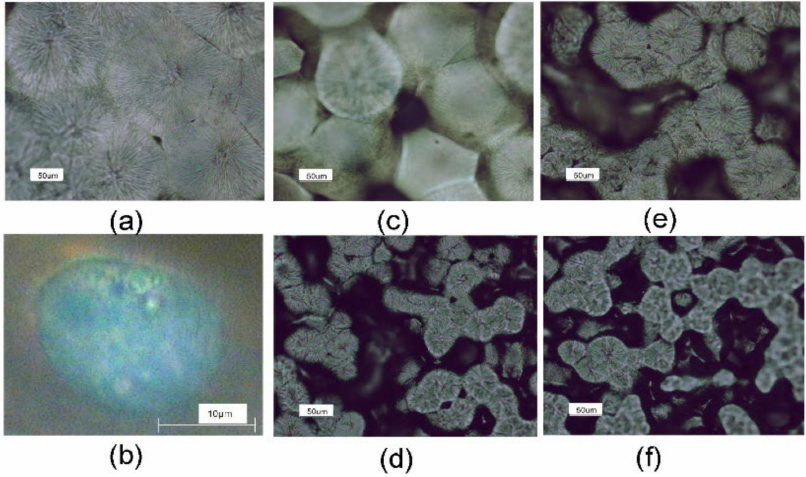
Figure 2. Microphotograph of the membrane top face: ( a ) PCL; ( c ) PCL/MWCNTs; ( d ) PCL/ESCNFs; ( e ) PCL/MWCNT-f and ( f ) PCL/ESCNFs-f, magnification 20 × ; ( b ) U-2 OS human cell on PCL/MWCNTs on the first day of culture, immersion objective, magnification 60 ×